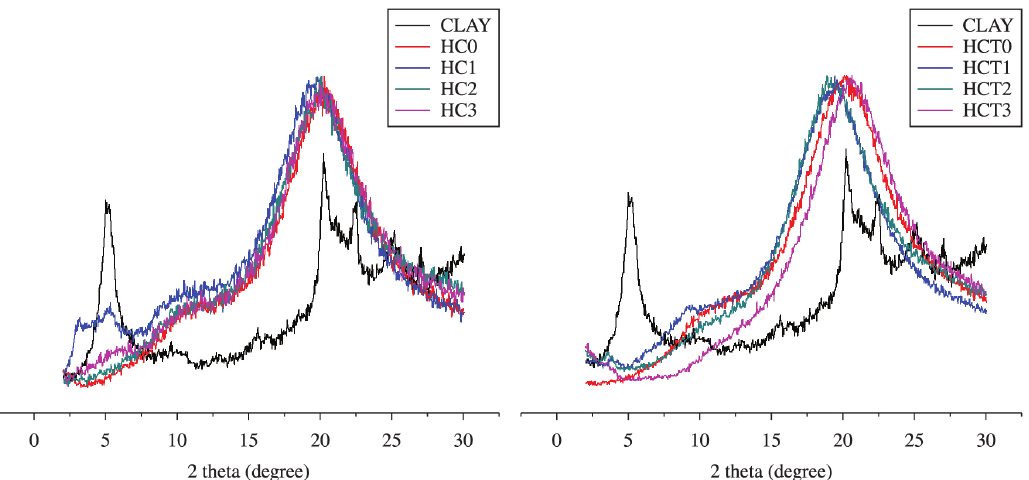
Figure 1. The X-ray diffractograms of clay and nanomaterials with HIPS samples prepared with chloroform (HC) and chloroform/ toluene (HCT).